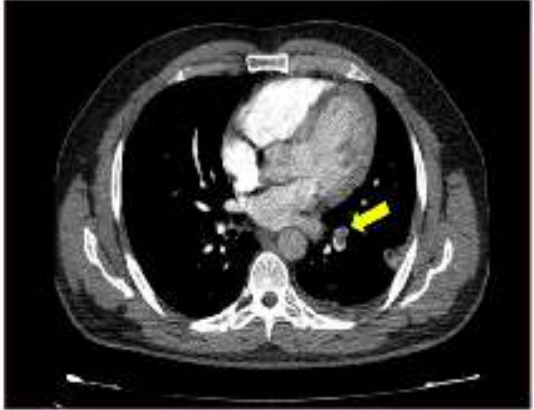
Figure 1 : The CT angiography revealed filling defect in the left inferior lobar branch of the pulmonary